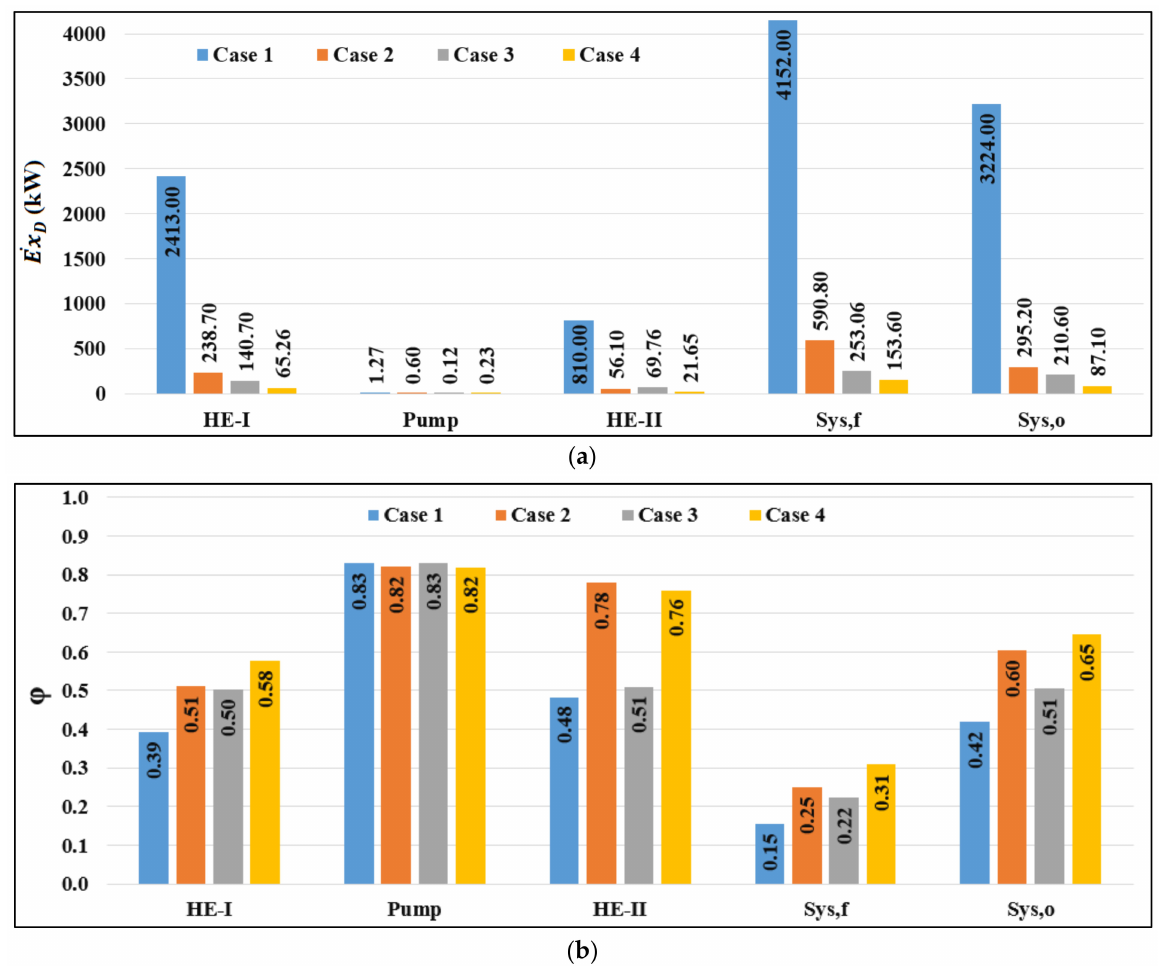
Figure 4. Conventional exergy assessment results based on ( a ) exergy destruction rate and ( b ) exergy efficiency.